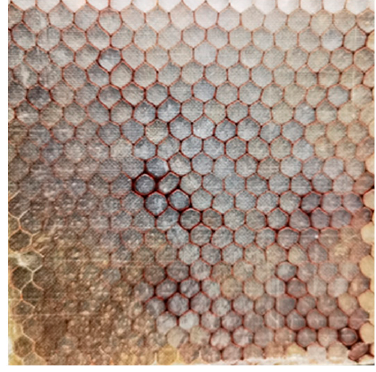
Figure 1. UAV skin sample.